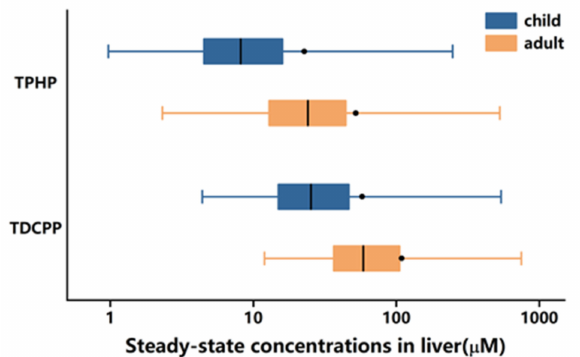
Figure 2. Predicted C ss of TPHP and TDCPP in the liver of children and adults following a daily dose of 1 mg/kg/day. C ss derived from PBTK simulation are presented with box-whisker plots.